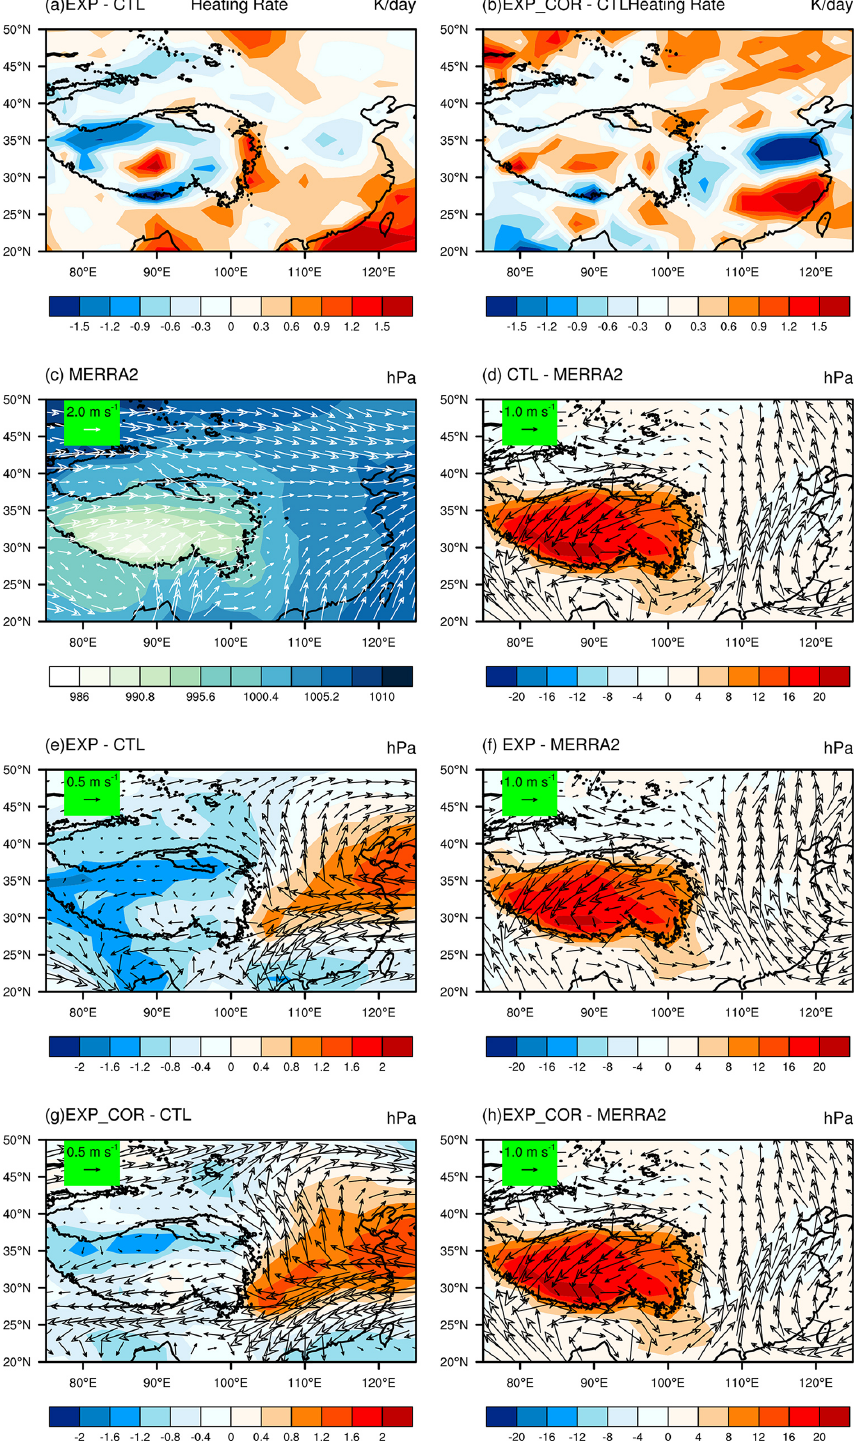
Figure 6. Spatial distributions of the differences of JJA-mean PBL heating (a) between EXP and CTL and (b) between EXP_COR and CTL; SLP superposed by the vector V from (c) MERRA-2; and the differences (d) between CTL and MERRA-2, (e) between EXP and CTL, (f) between EXP and MERRA2, (g) between EXP_COR and CTL, and (h) between EXP_COR and MERRA2. The vector V is defined in Eq.